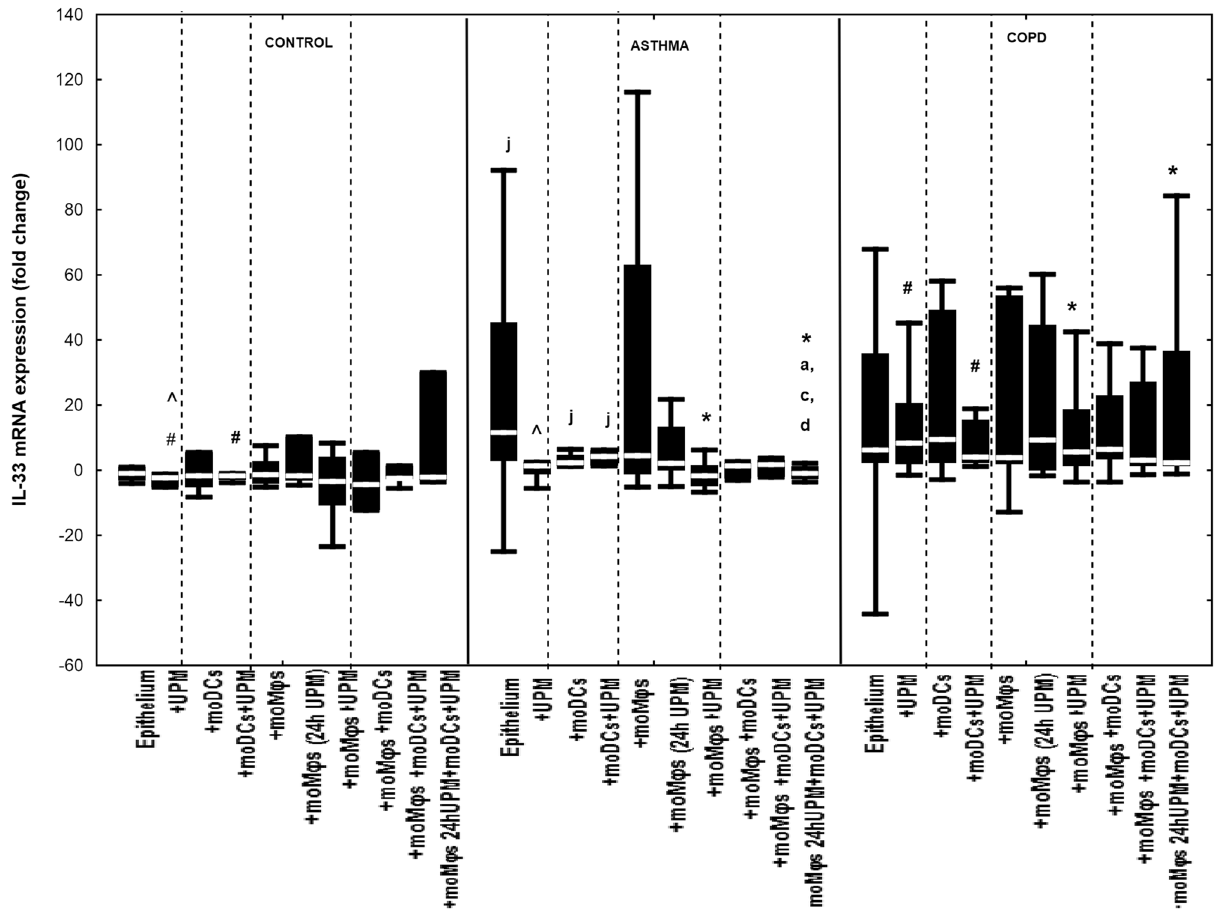
Figure 8. IL-33 mRNA expression in air–liquid interface (ALI) after 24 h UPM exposure in multi co-culture schemes in control subjects, asthma and COPD patients. The data are shown as non-outlier range (whiskers), interquartile range (box) and median (line); p value calculated using Mann–Whitney U test. The p value < 0.05 in comparison to: a—epithelium, b—epithelium + UPM, c—epithelium + moDCs, d—epithelium + moDCs + UPM, e—epithelium + moMφs, f—epithelium + moMφs (24 h UPM), g— epithelium + moMφs + UPM, h—epithelium + moMφs + moDCs, i—epithelium + moMφs + moDCs + UPM, j—epithelium + moMφs (24hUMP) + moDCs + UPM; ^ asthma versus control, # COPD versus control, *asthma versus